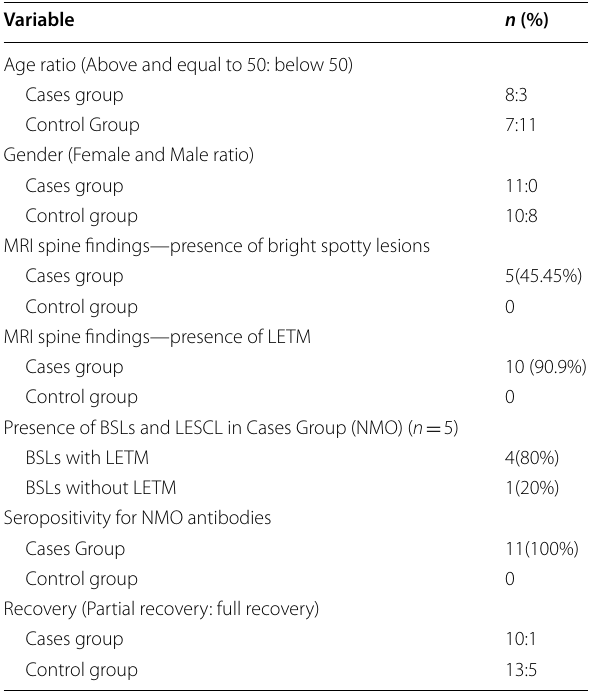
NMO: neuromyelitis optica; BSLs: bright spotty lesions, LETM: longitudinal extensive transverse